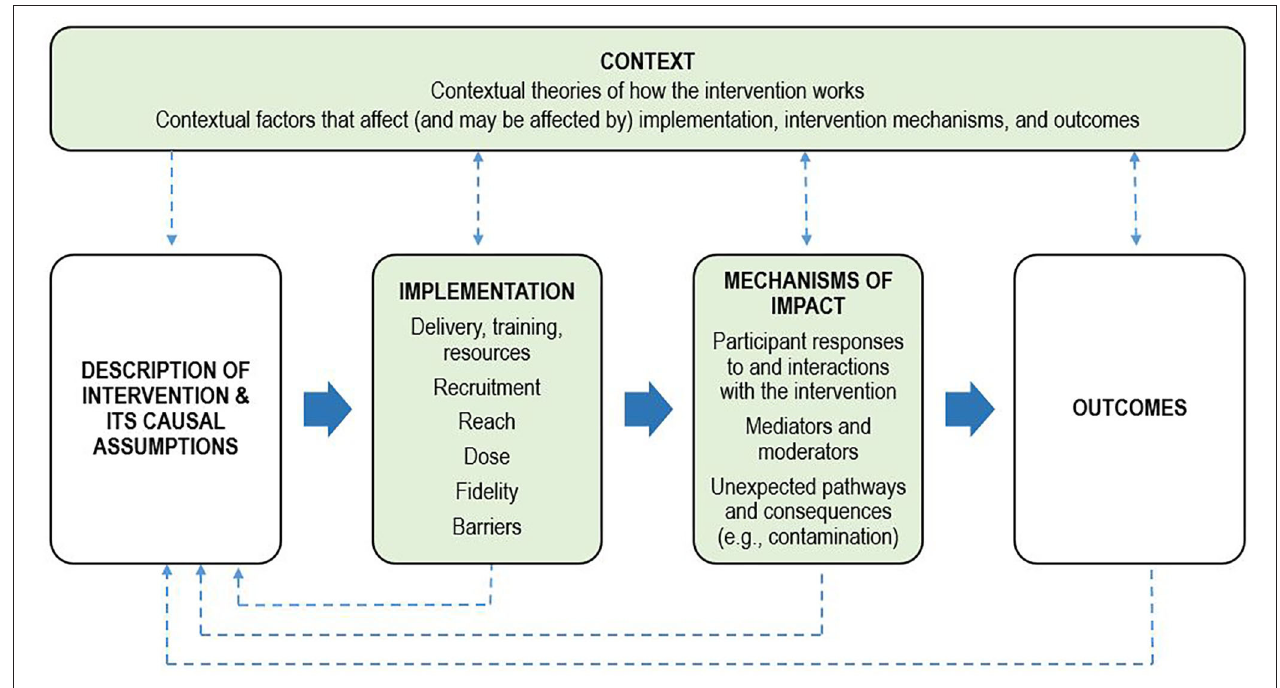
FIGURE 1 | Process evaluation framework. Adapted from the UK Medical Research Council framework for conducting and reporting process evaluation studies (Moore et al., 2015). Key components of the process evaluation are in green boxes. Investigation of these components is shaped by clear descriptions of the intervention and its causal assumptions. Implementation refers to how the intervention was delivered, and mechanisms of impact refers to how the intervention produced change. The dotted lines indicate the relations between context, the intervention, implementation, mechanisms, and